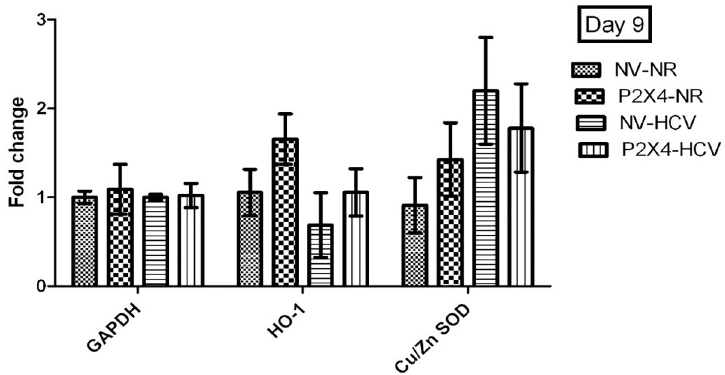
Fig 14. Expression of antioxidants on day 9 of post infection. All values are expressed as mean ± SEM, � P � 0.05 vs. control NV/HCV.